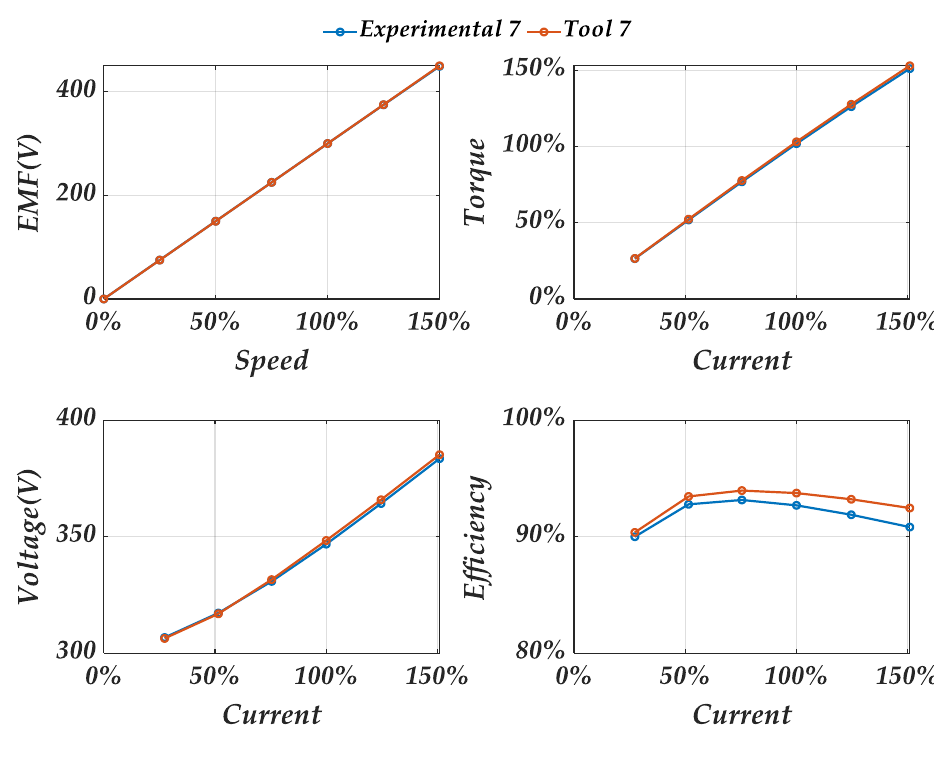
Figure 17. Comparison between experimental and calculated results in the M7